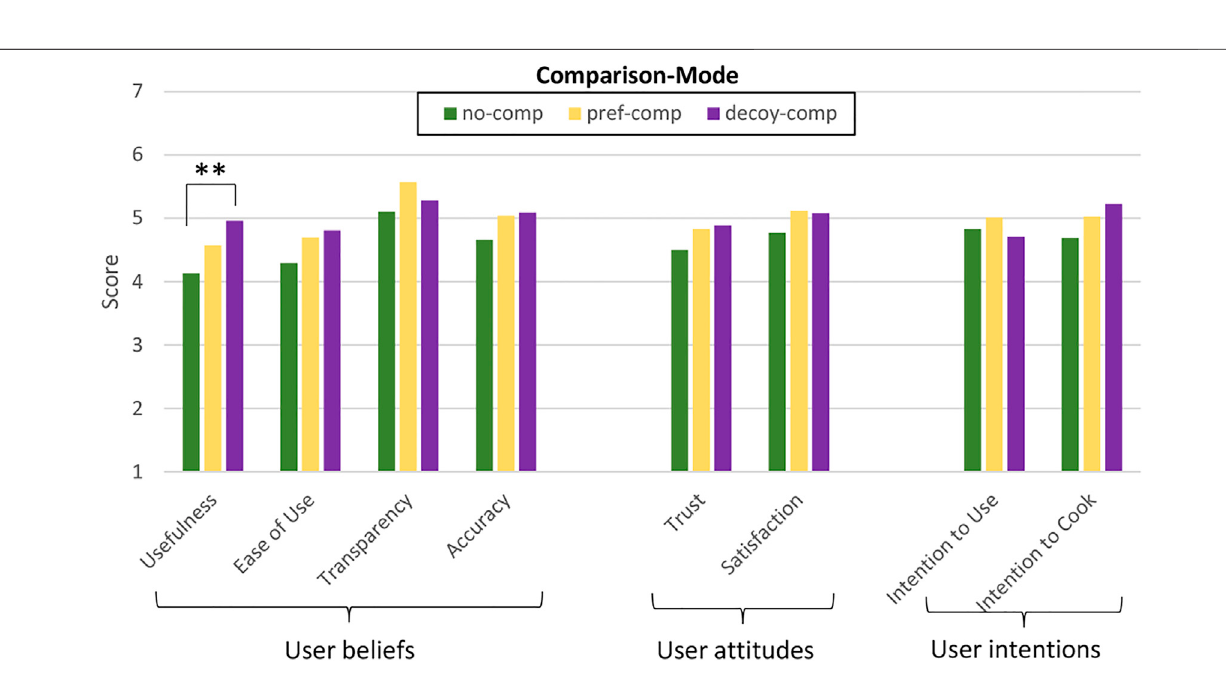
Frontiers in Robotics and AI |